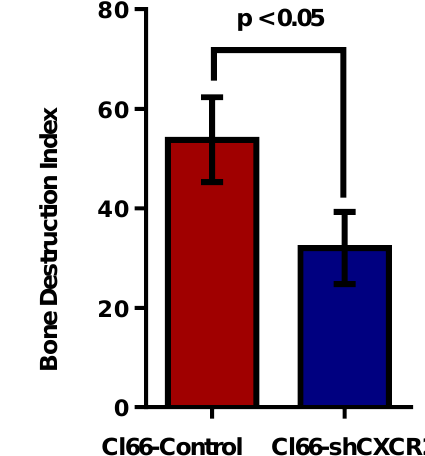
Figure 2. CXCR2 downregulation in Cl66 cells significantly decreased tumor-induced osteolysis. ( A ) Representative images show H&E staining demonstrating intact cranial bone in